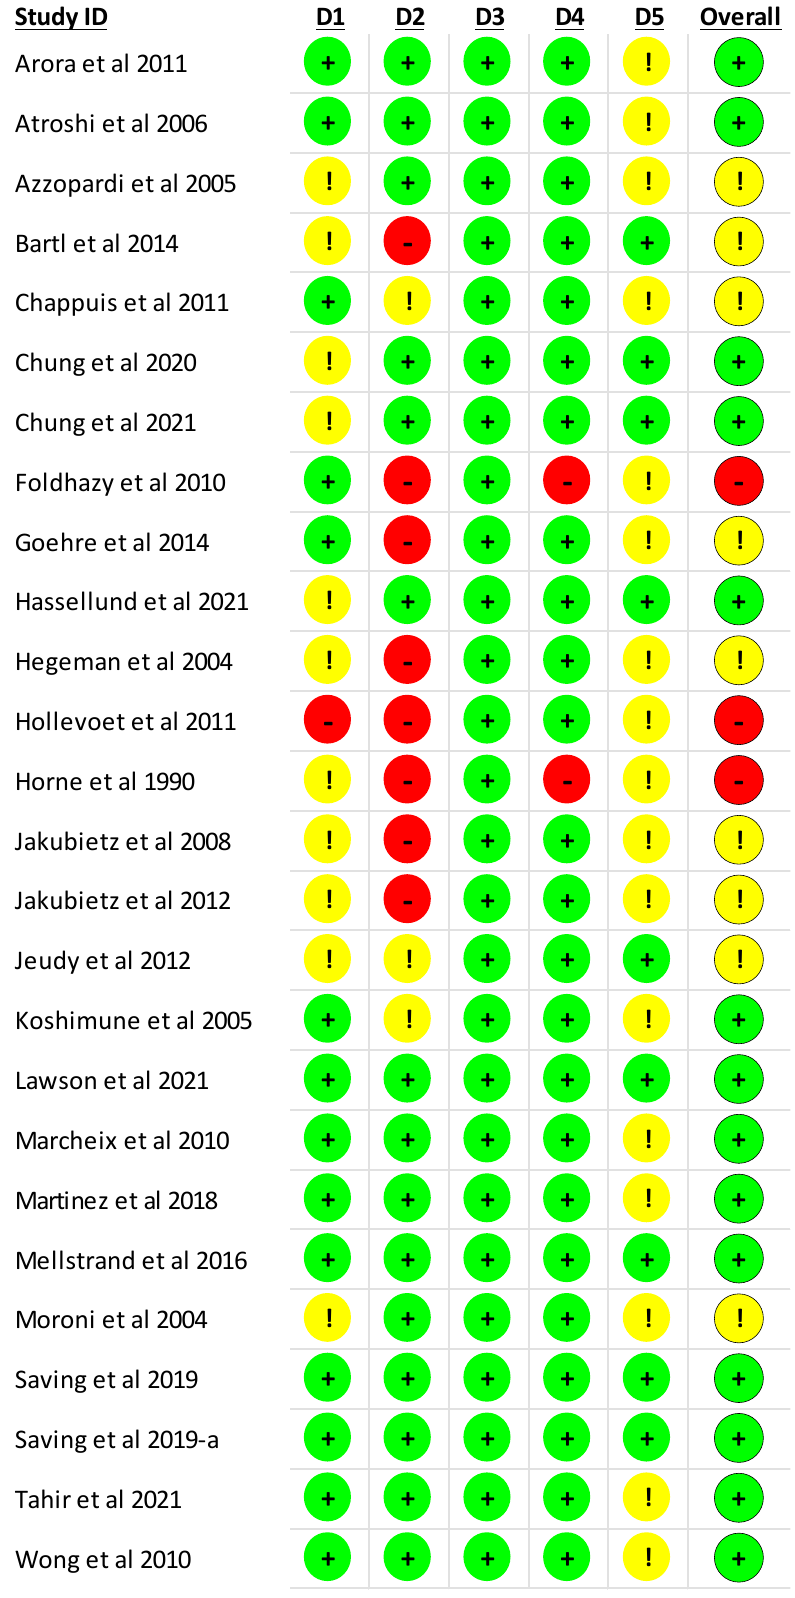
Figure 2. Risk of bias summary: review authors’ judgements about each risk of bias item for each included study [29–54]. Note: “low,” (green ball or “+”) “unclear,” (yellow ball or “!”) and “high” (red ball or “-“) Risk of bias.